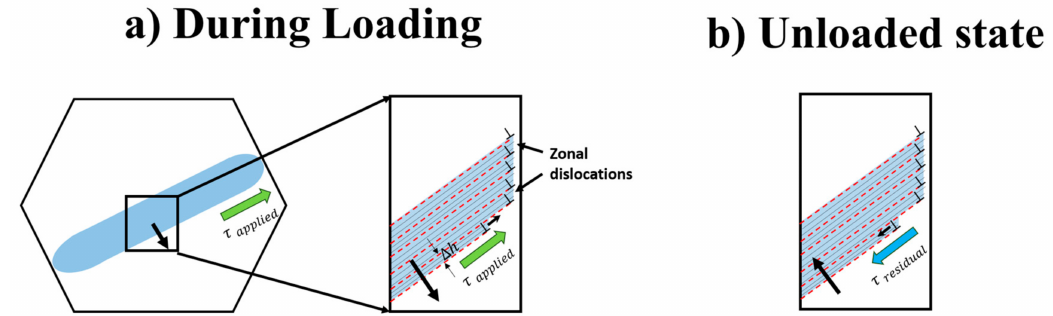
Figure 6. ( a ) Schematic showing twin boundary migration leading to twin broadening under applied stress; the stress component parallel to the twin boundary drives the motion of zonal dislocations that result in simultaneous shearing and twin thickening i.e., shear coupled twin boundary motion ( b ) In unloaded state, compressive residual stress states can exert negative shear forces and subsequently favor opposite movement of twinning dislocations and concurrent twin shrinkage i.e.,